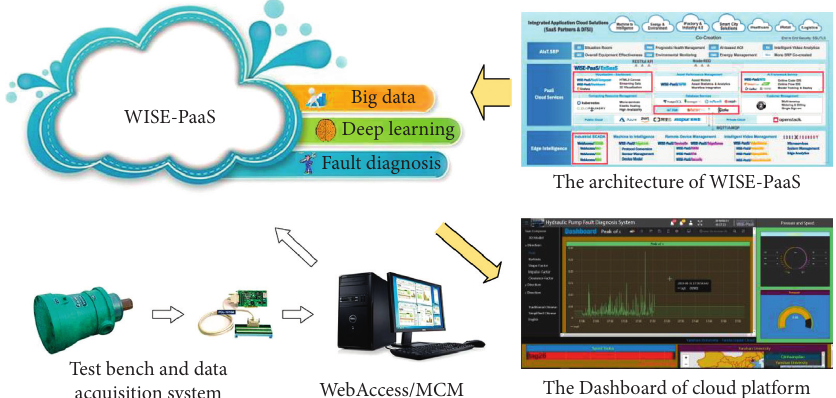
Figure 20: Hydraulic pump fault diagnosis system based on cloud